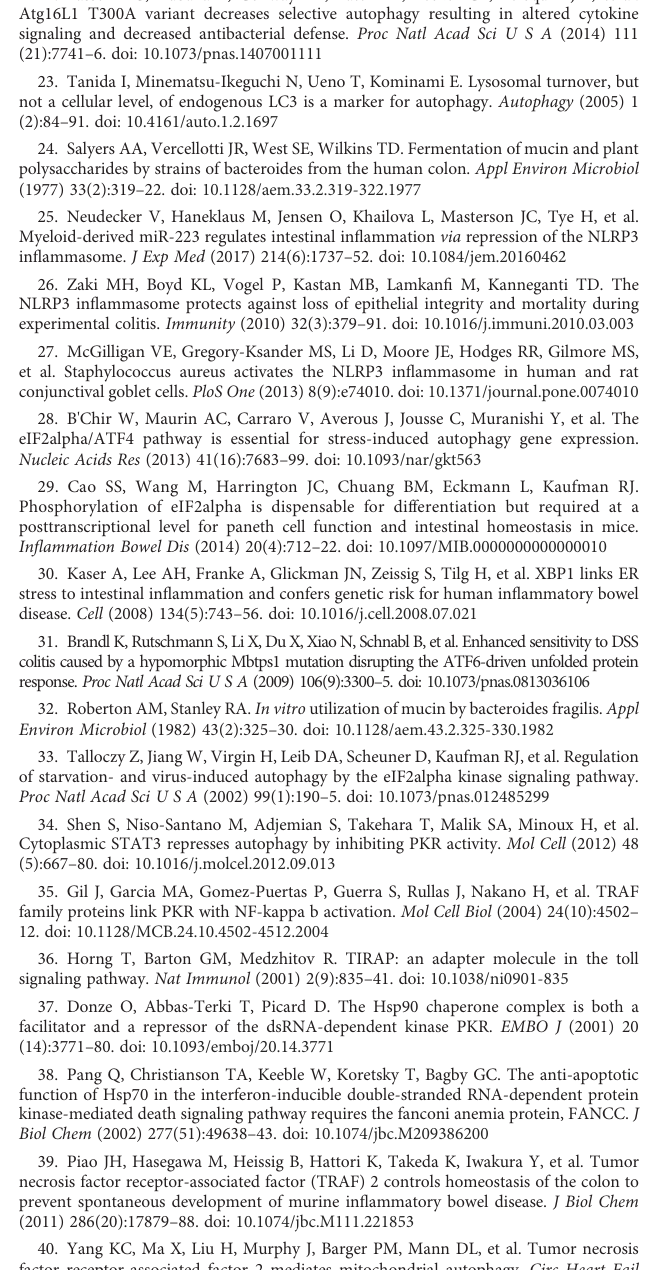
SUPPLEMENTARY FIGURE 3 Con fi rmation of PKRs ablation in Eif2ak2 -/- cells. An immunoblot with an anti- PKR antibody detecting PKR in whole-cell lysates and peptides captured with a heparin column from embryonic fi broblasts isolated from WT or the Eif2ak2 -/- mice reported by Yang et al. (9) (on left) and the Coomassie-stained resolving gel after electrophoretic transfer to demonstrate the relative peptide levels (on right). The full-length PKR has been cleaved during this process so that the truncated kinase domain is the principal peptide detected in the WT lysates, while no PKR peptide is detected in the Eif2ak2 -/-